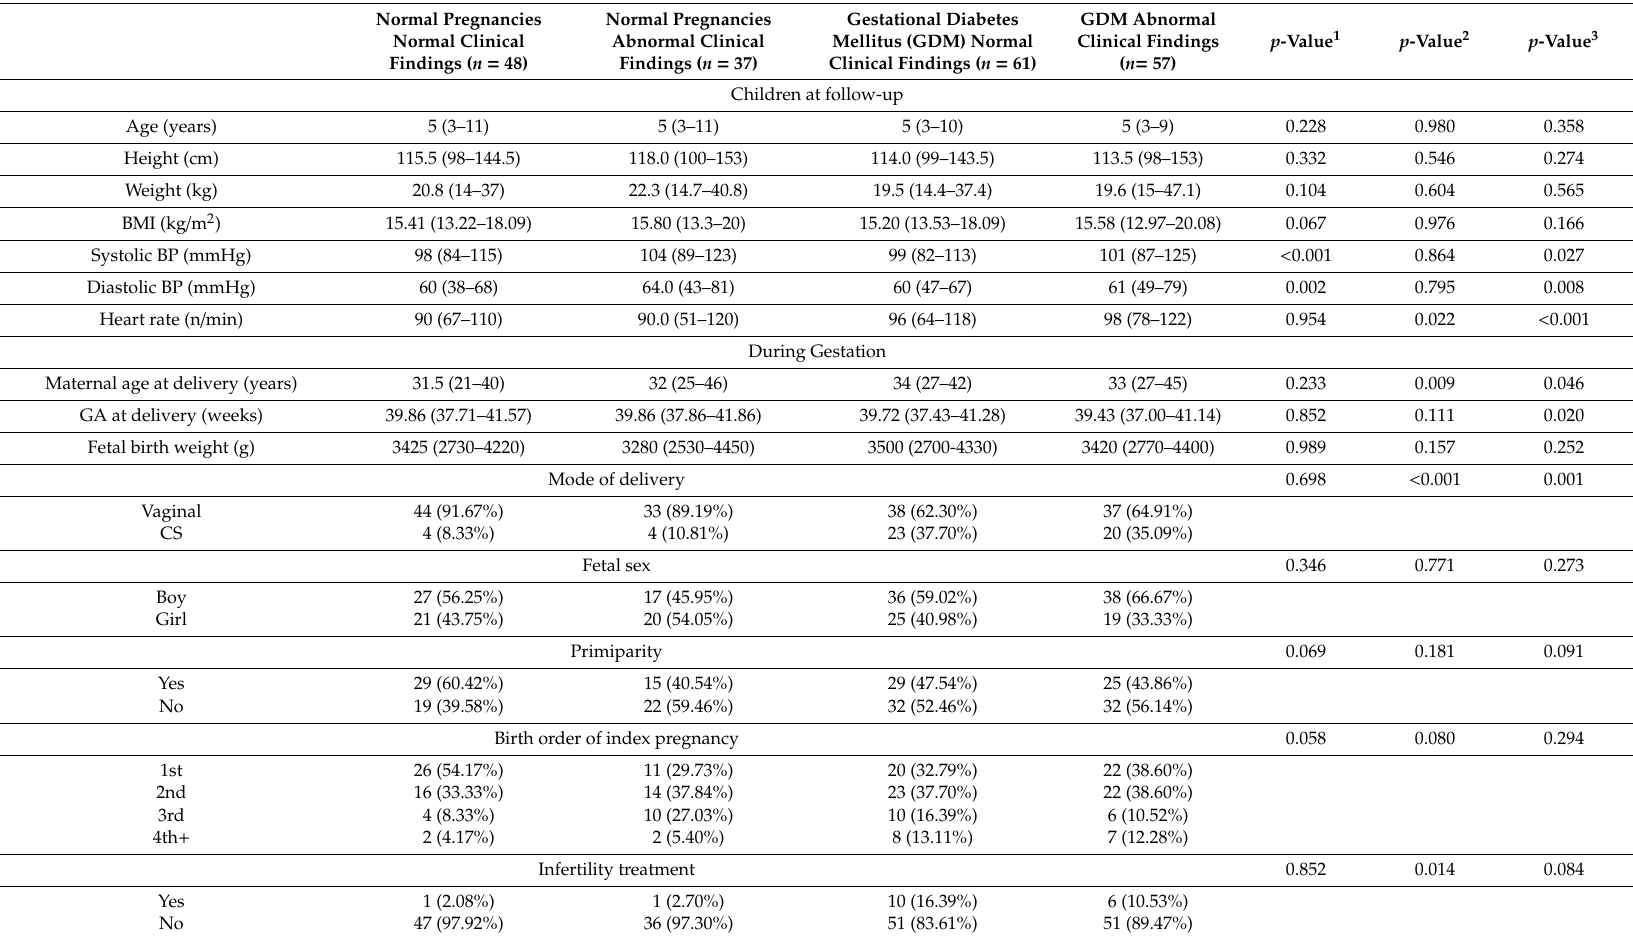
Table 2. Characteristics of cases and